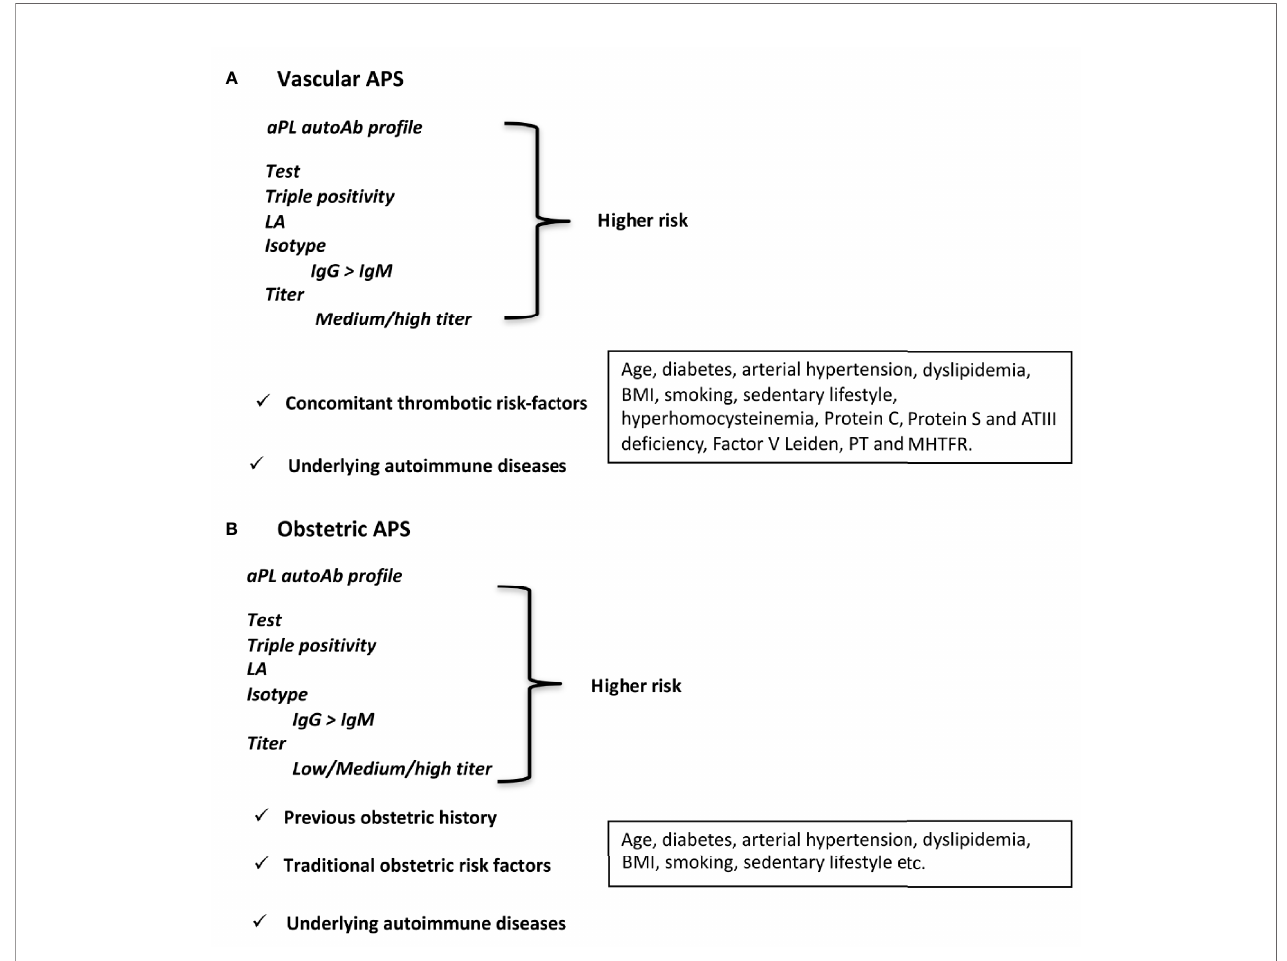
FIGURE 1 | Antiphospholipid antibodies as a risk factor. aPL pro fi le, isotype, titer, and aPL-unrelated factors de fi ning higher risk for (A) vascular APS and (B) obstetric